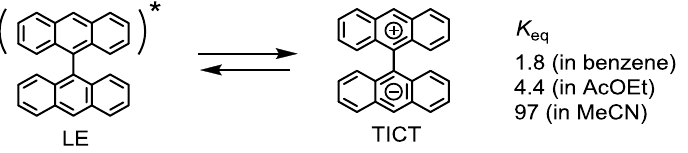
Figure 14. Charge separation in